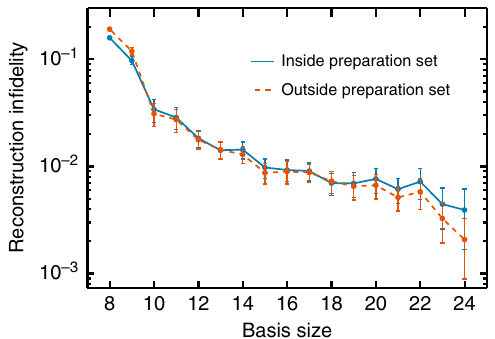
Fig. 7 Reconstruction in fi delity for a process tensor experiment on